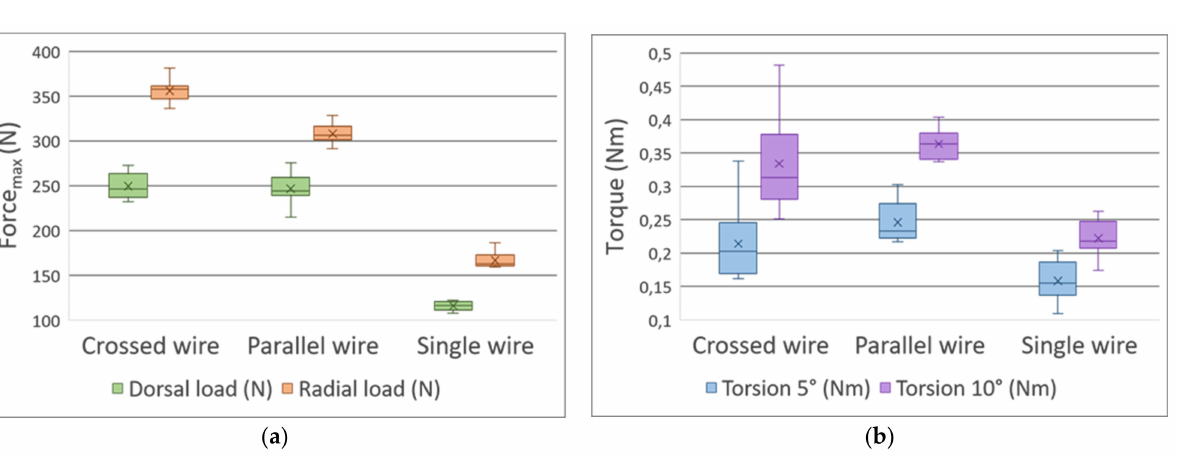
Figure 8. Box plots of the ( a ) three-point bending and ( b ) torsion tests, regarding the different fixation methods. The radial, dorsal loads, and the 5 ◦ and 10 ◦ torsions are coded using various